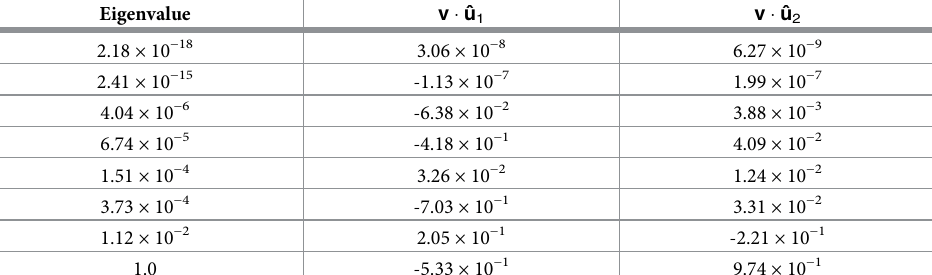
Table 2. Orthogonality between the model-map and uninformative directions. We tabulate the eigenvalues of the FIM relative to the largest eigenvalue, and the dot product between each corresponding eigenvector and rows of the Jacobian of the Ward and King to logistic